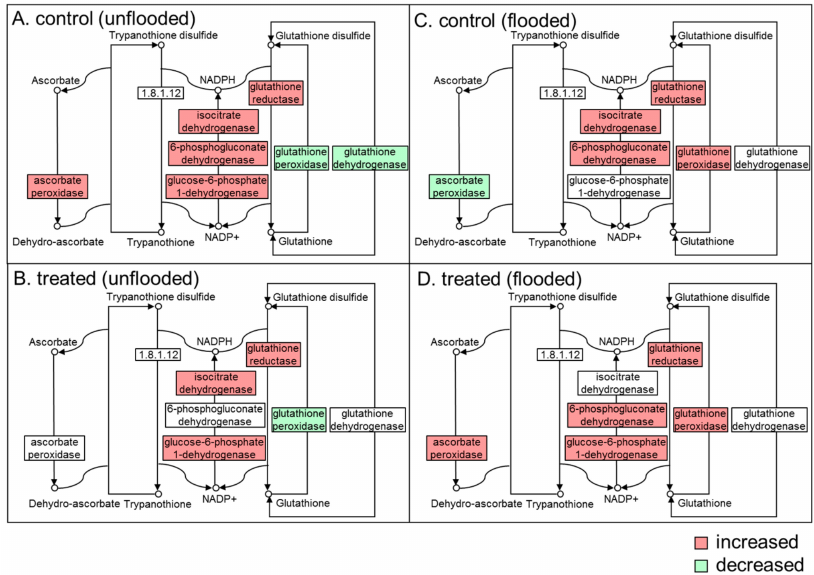
Figure 5. Mapping of di ff erentially changed proteins that related to ascorbate and glutathione metabolism identified from irradiated (treated) / unirradiated (control) soybean root. Proteins were extracted from flooded and unflooded soybean seedlings. ( A ) Mapping from unirradiated soybean under unflooded conditions. ( B ) Mapping from irradiated soybean under unflooded conditions. ( C ) Mapping from unirradiated soybean under flooding. ( D ) Mapping from irradiated soybean under flooding. Proteins neither detected nor changed are marked in white. The number in the box indicates the enzyme commission number of corresponding